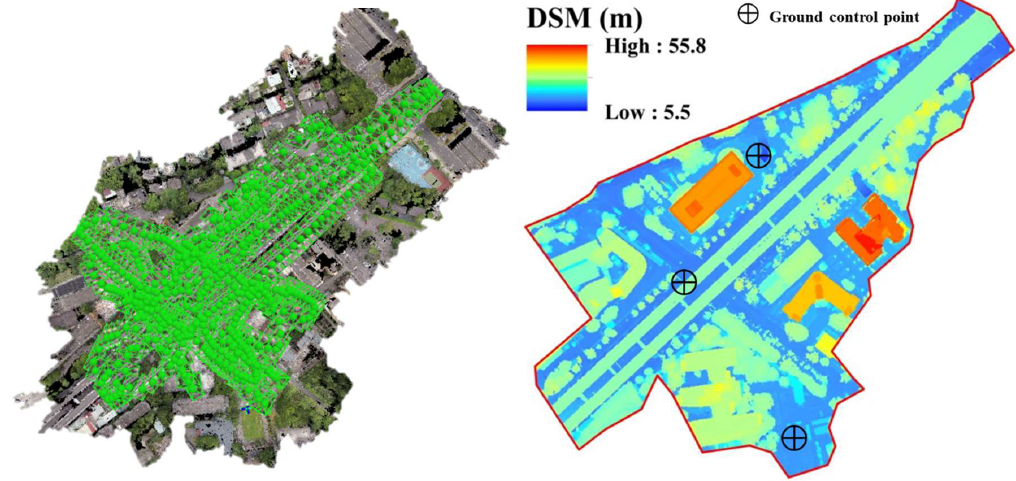
Figure 4. 589 positioned unmanned aerial vehicle images generated a UAV orthophoto ( left ) and DSM with 0.03-m ground resolution ( right) .